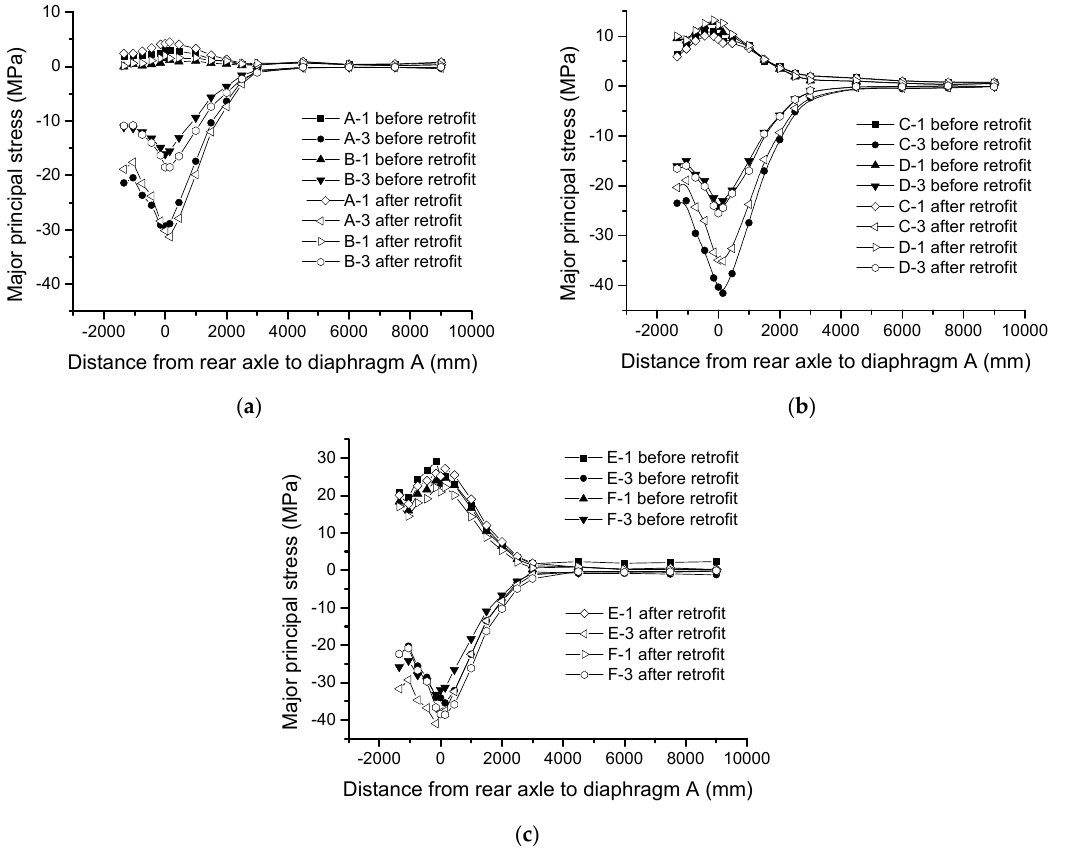
Figure 19. The relationship between the longitudinal loading position and the stresses on the diaphragm: ( a ) the stresses at the horizontal line, ( b ) the stresses at the 45° direction line, ( c ) the stresses at the straight line parallel to the U-rib web.